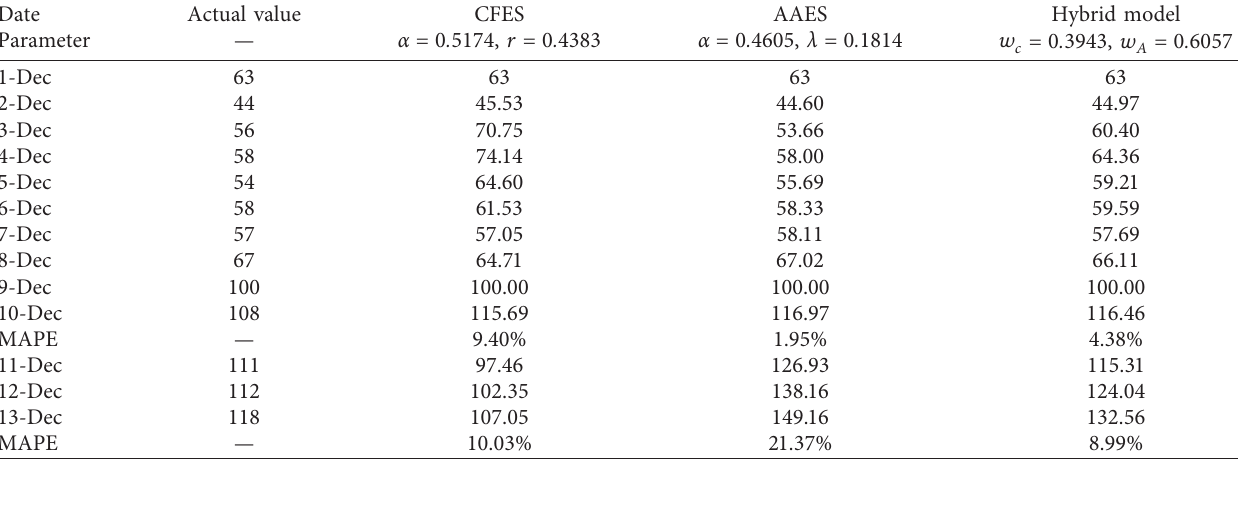
Table 5: The forecasting results of AQI concentration.